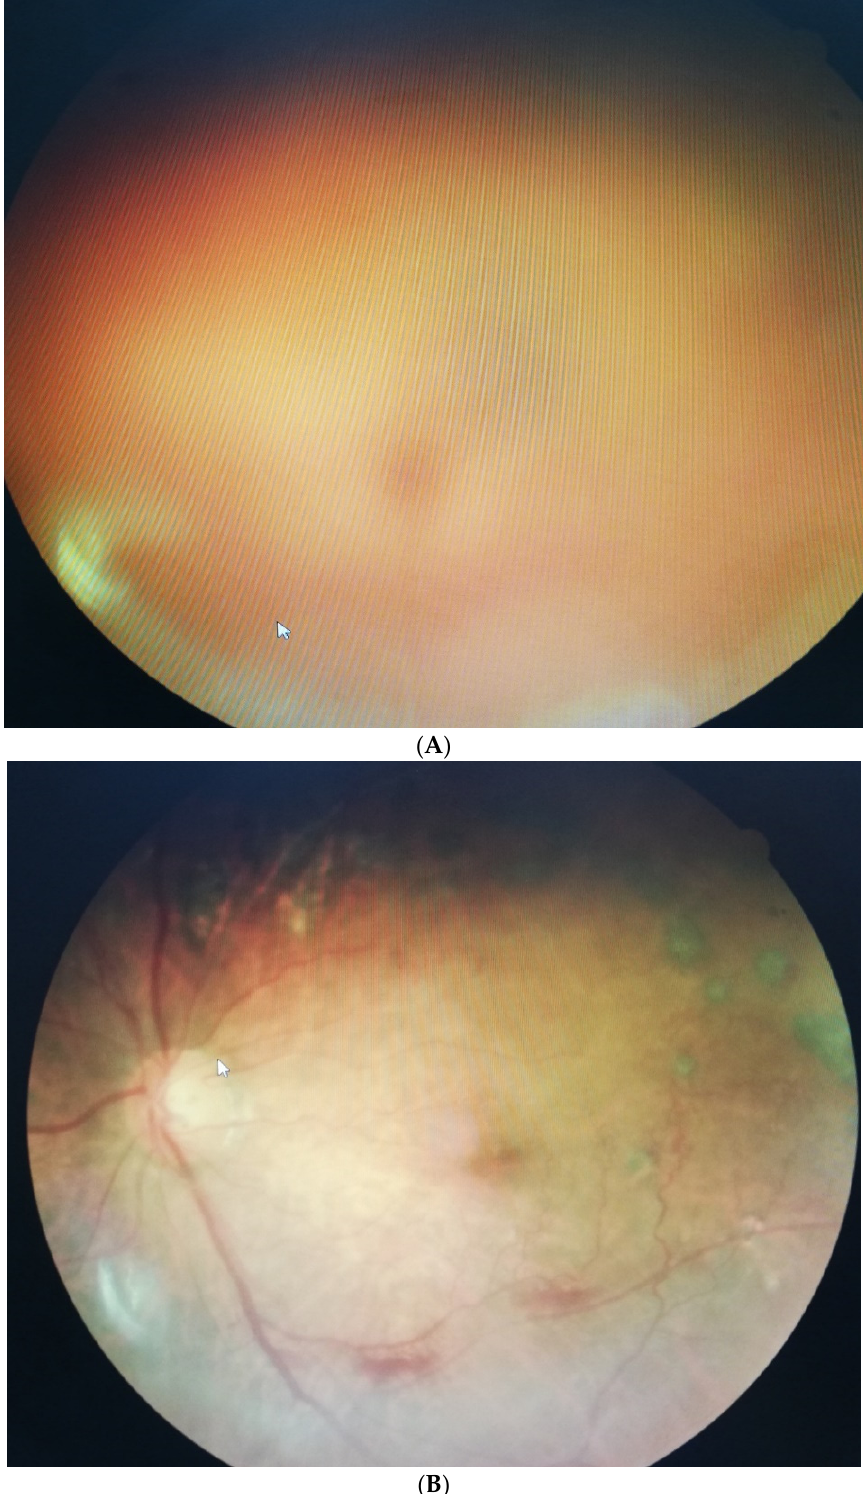
Figure 2. ( A ) A male DM patient aged 58 presented obvious VH-induced SVOs at the beginning of our study. The dark-red cloud overlapped the retinal fundus. ( B ) VH-induced SVOs gradually diminished after a three-month mixed fruit enzyme supplement. The patient’s vision improved from 6/60 to 30/60.